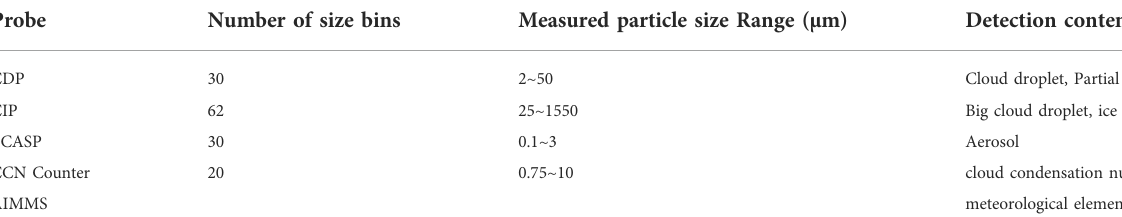
TABLE 1 Aircraft platform and onboard instruments.